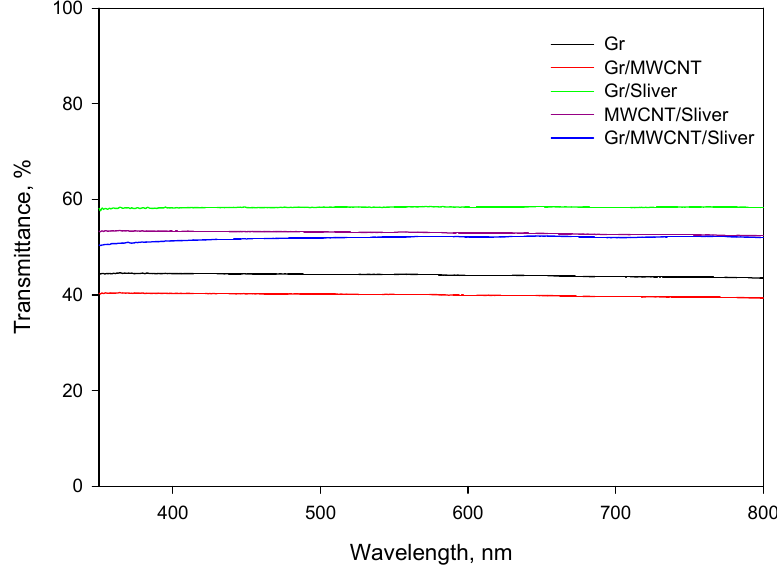
Figure 7. Transmittance of the coated films.